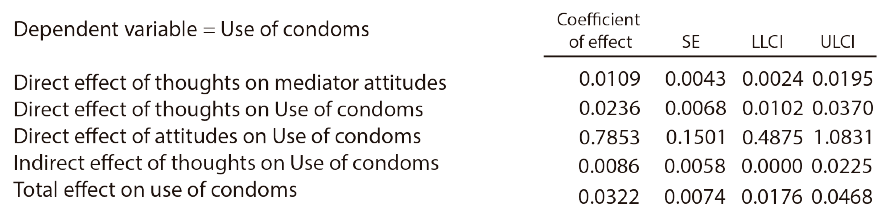
Figure 3. Mediation model for thoughts, attitudes, and use of condoms. Thoughts: predictor variable, attitudes: mediator, use of condoms: outcome variables (a = unstandardized coefficient of thoughts on attitudes; b = unstandardized coefficient of attitudes on use of condoms; ab = indirect effect of thoughts on use of condoms; c ´ = direct effect of thoughts on use of condoms; c = total effect of thoughts on use of condoms = ab +